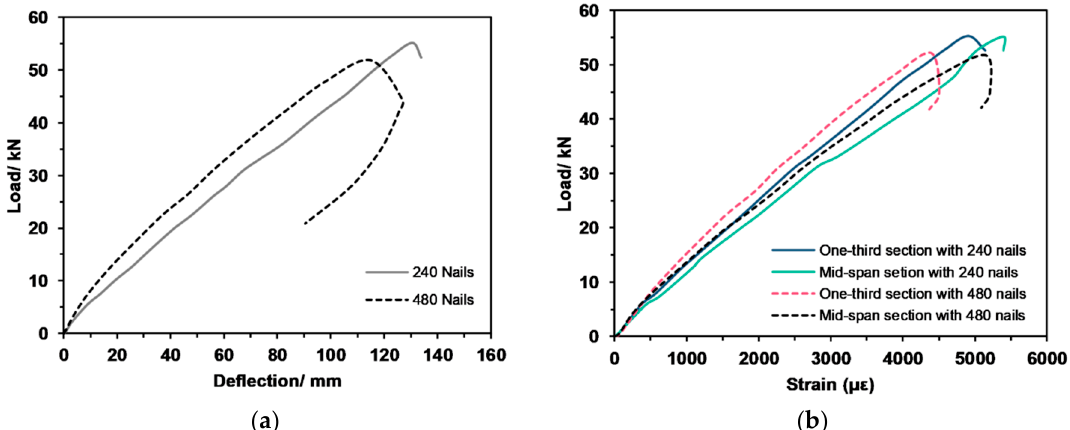
Figure 12. E ff ect of nail number on load-deflection and load-strain relationship. ( a ) Load-deflection Figure 12. Effect of nail number on load ‐ deflection and load–strain relationship. ( a ) Load ‐ deflection curves of specimens with a di ff erent number of nails; ( b ) Load-strain curves of mid-span and one-third curves of specimens with a different number of nails; ( b ) Load–strain curves of mid ‐ span and one ‐ sections in the specimens with a di ff erent number of third sections in the specimens with a different number of nails.